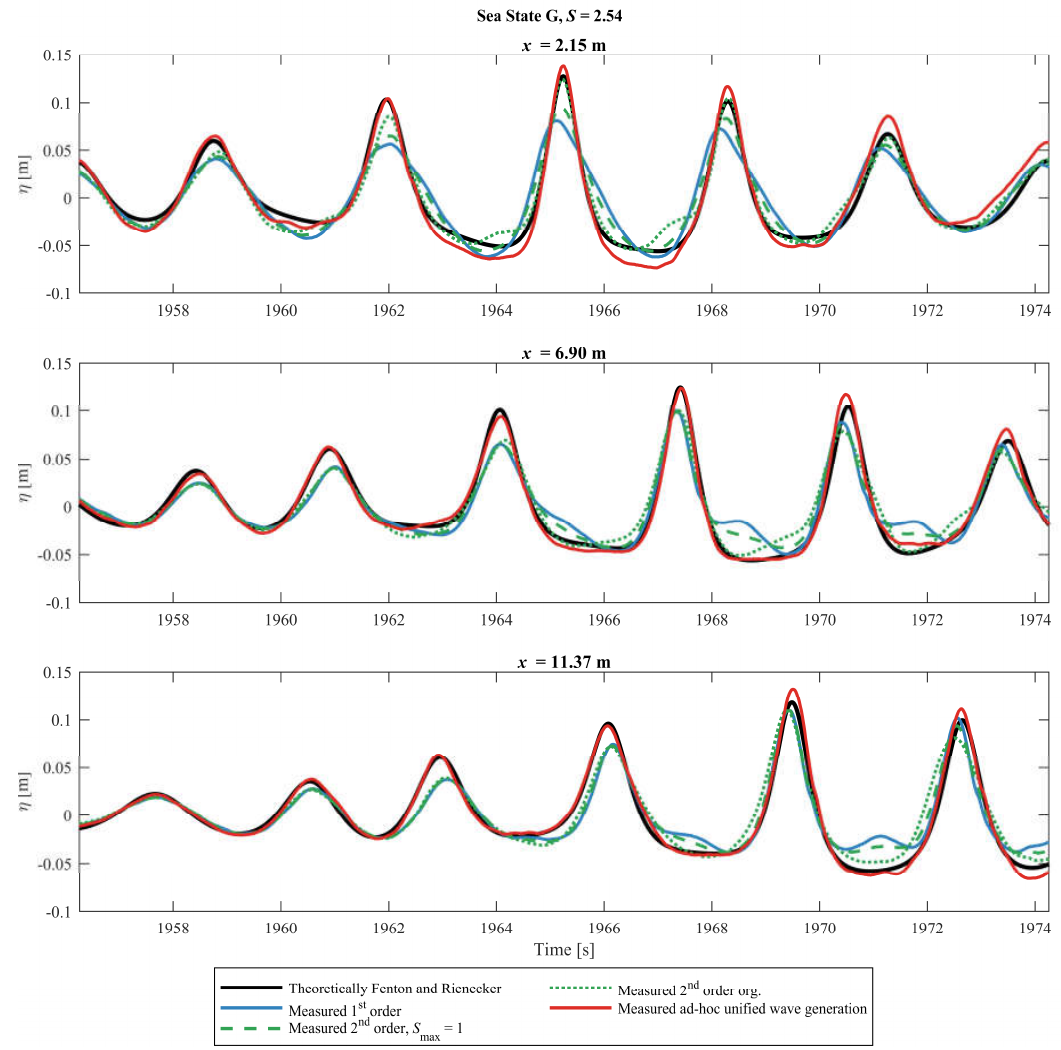
Figure 12. Numerically surface elevation compared with the first-order, second-order, modified second-order and the ad-hoc unified wavemaker methods for Sea State G.